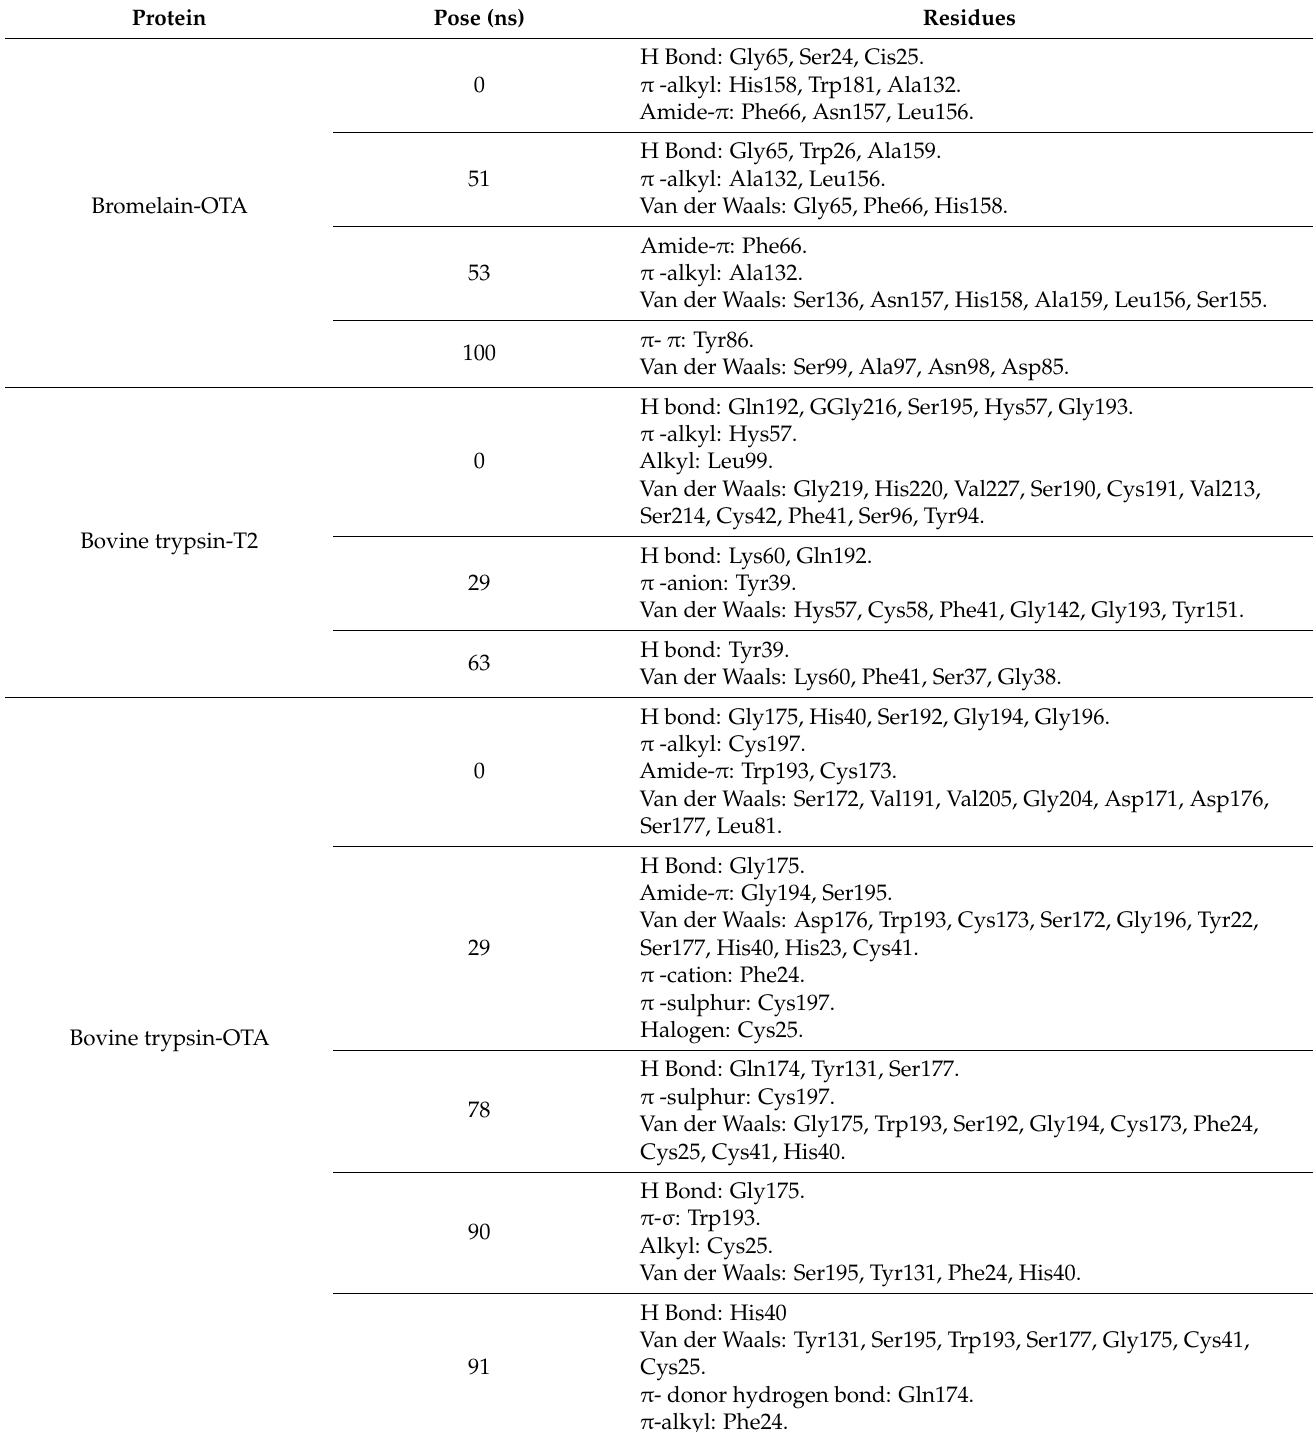
Table 4. Protein–ligand main poses in molecular